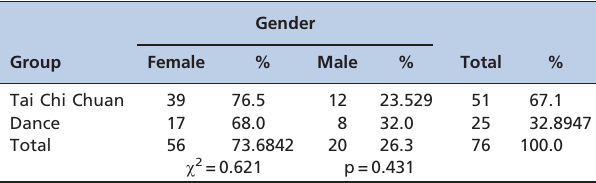
Table 1 - Characterization of the sample by gender and